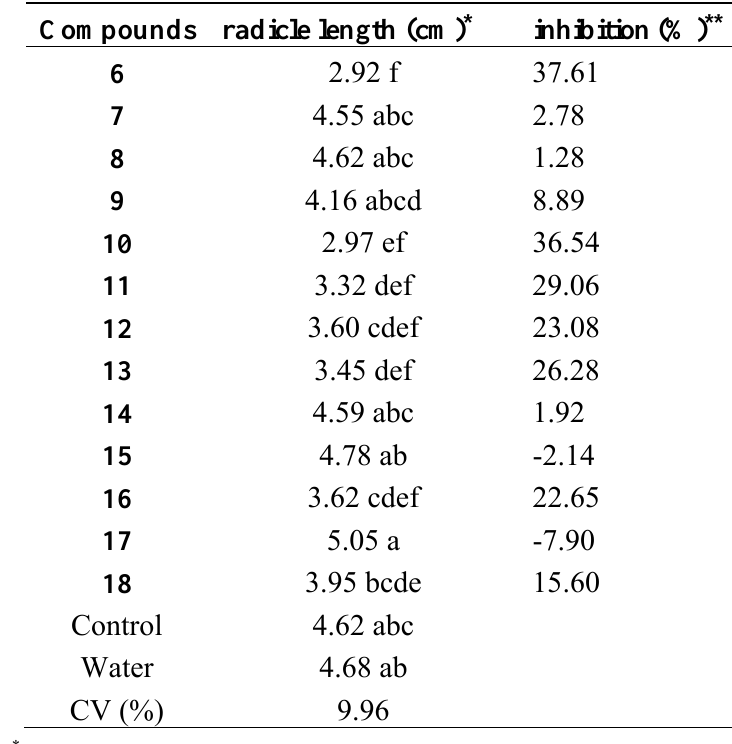
Table 1 . Effect of Oxabicycles 6 - 18 on Radicle Growth of Cucumis